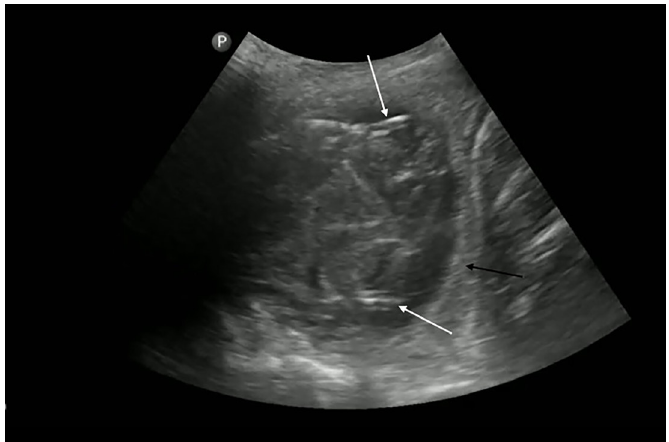
Image 3. Point-of-care ultrasound of the left hemithorax showing the “honeycomb” appearance of a multivesicular cyst with double echogenic lines 6 (white arrows) known as the “wall sign” 5 and internal “serpentine” linear structures delineating the daughter cysts. 6 This cyst occupies nearly the entire volume of the left hemithorax (black arrow indicates the diaphragm).